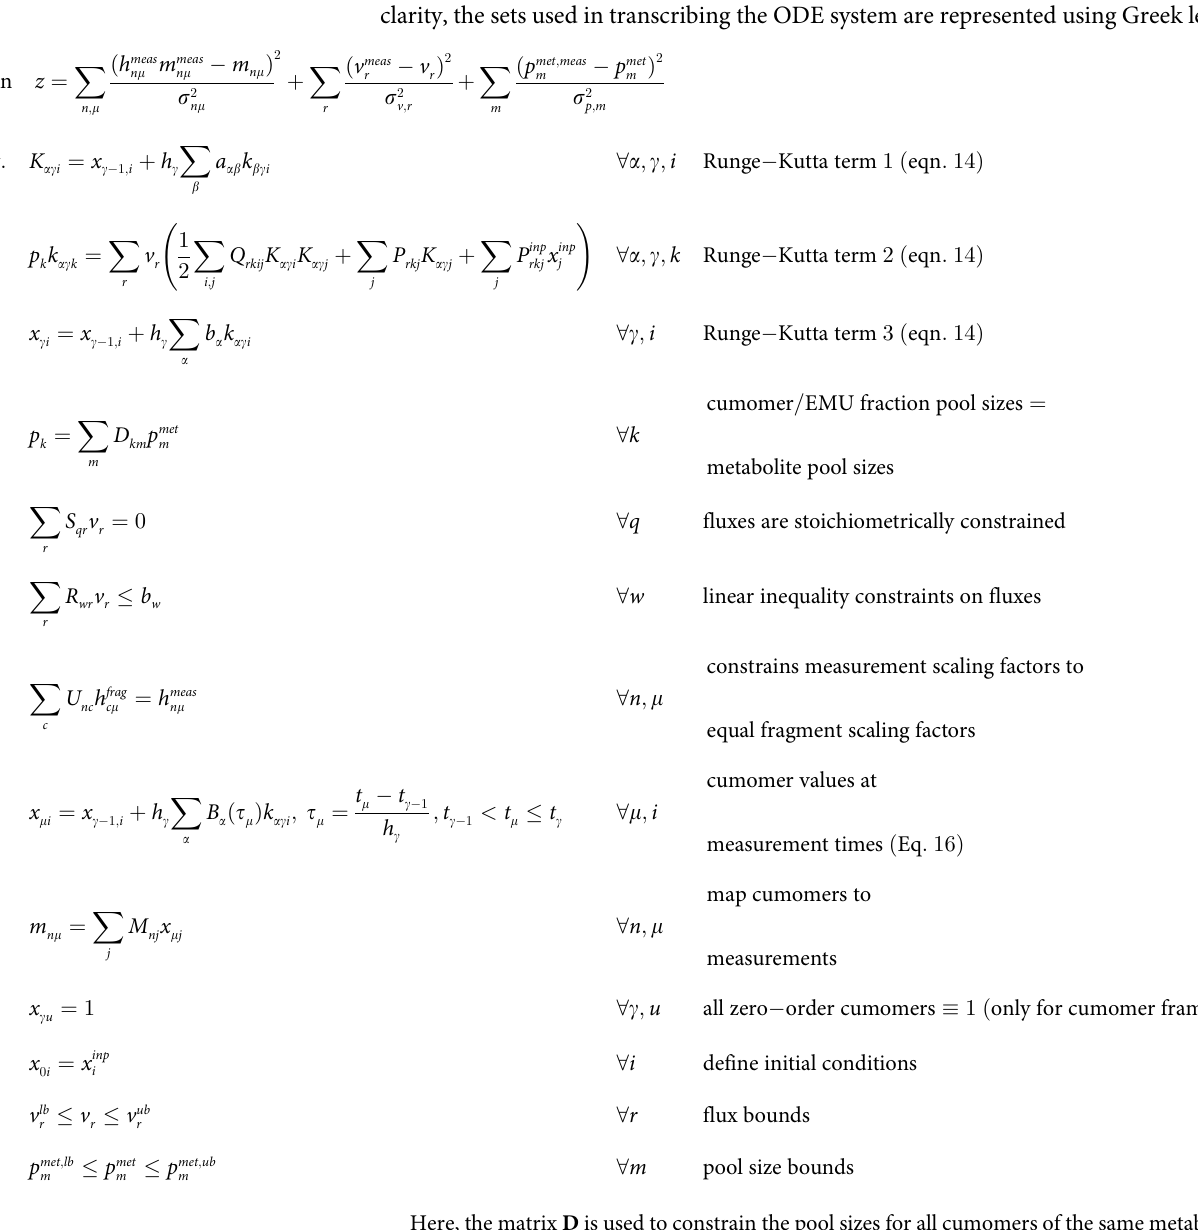
clarity, the sets used in transcribing the ODE system are represented using Greek letters.